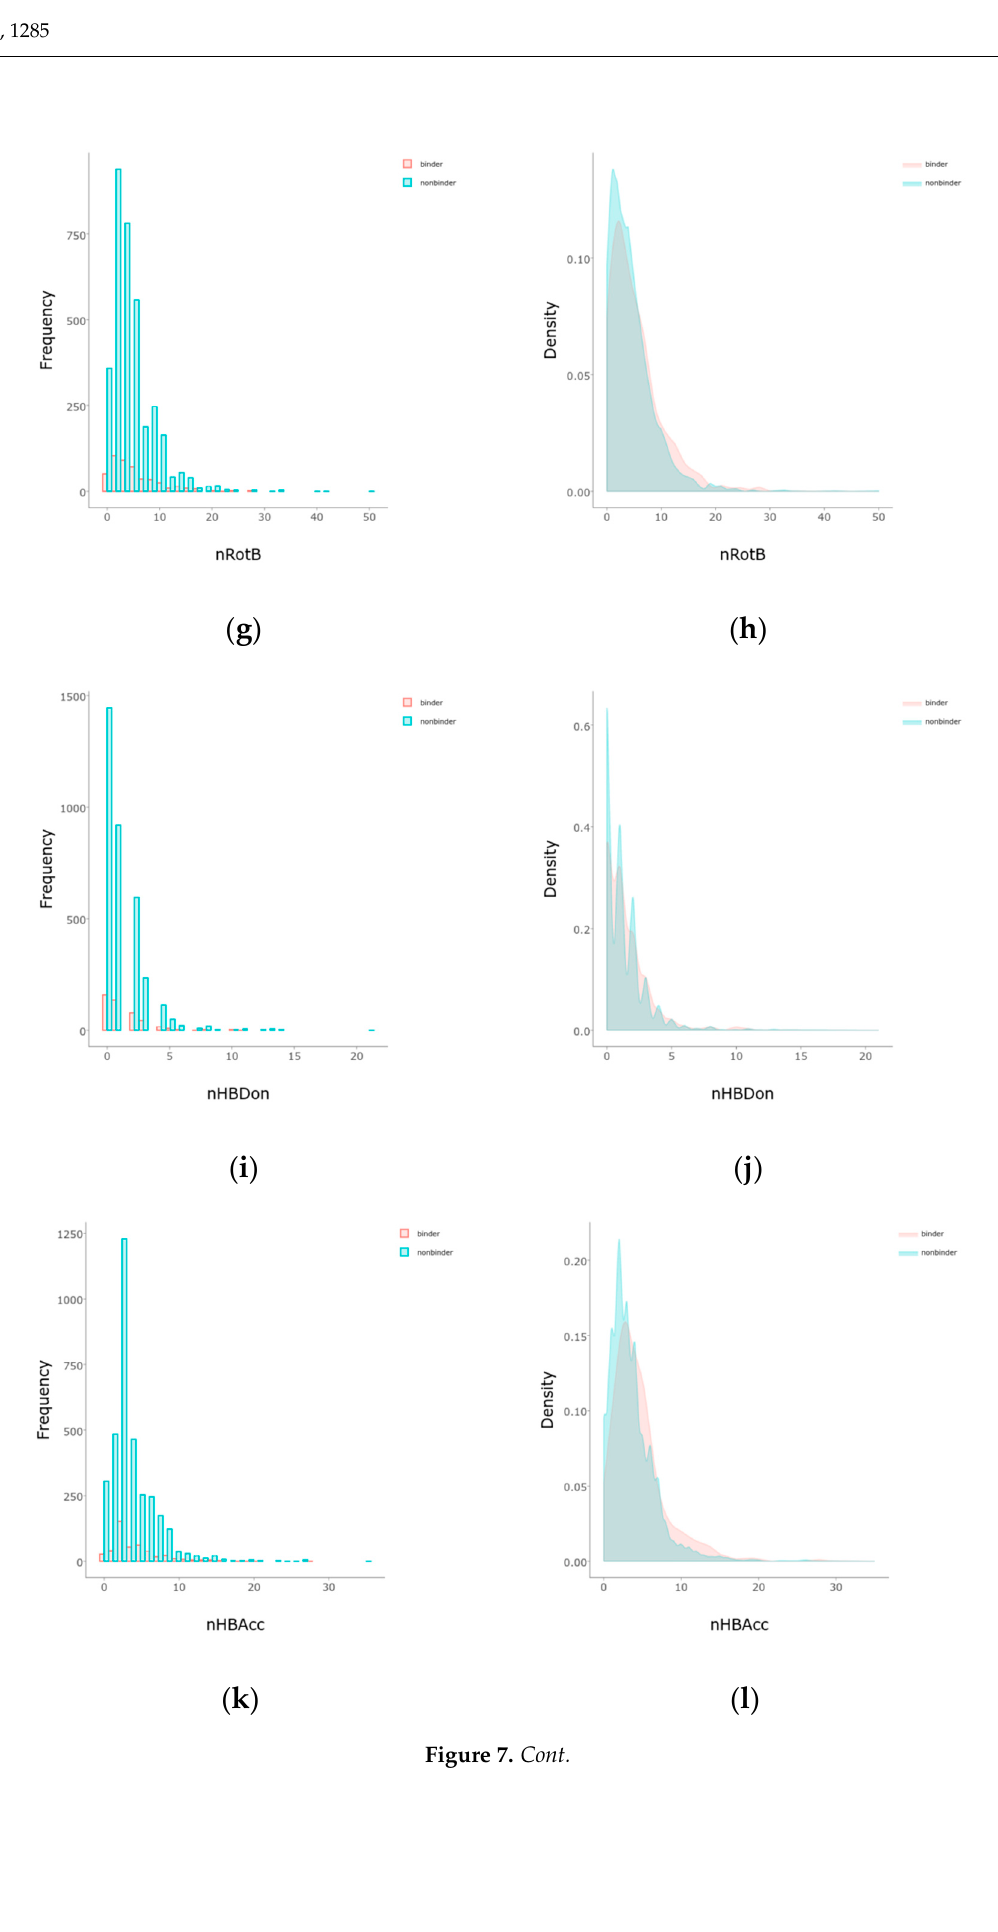
( n ) Figure 7. PUMA: ( a ) principal component analysis; ( b ) balance; and histograms and density plots for binders and non- binders in the evaluation dataset according to: ( c , d ) MW (g/mol); ( e , f ) TPSA (Å 2 ); ( g , h ) number of rotational bonds (nRotB); ( i , j ) number of hydrogen bond donors (nHBDon); ( k , l ) number of hydrogen bond acceptors (nHBAcc); and ( m , n ) Alog P . 2.4. Validation of Docking and Comparison to Other Methods Decoys were generated for the androgen receptor using the DUD-E database (http://wiki.bkslab.org/index.php/DUDE (accessed on 14 February 2021)) and Receiv- er-Operator Curves (ROCs) and Area Under the Curves (AUCs) for the Human, Chimp, and Rat androgen receptor docking scores were calculated and plotted (Figure 8), showing a good separation of true positive from false positives in the most important, i.e., initial parts of the curves. Their values are high, and the chimp protein again shows that it is the most suited with an AUC of 0.832, and an enrichment factor at 1% of 68.92. AUC for human was 0.797, and AUC for rat was 0.744. Comparing our results to a structure-based approach by Trisciuzzi et al. [7], they obtained the highest AUC of 0.76 for structures 2pnu and 2hvc, compared to 0.83 for the Chimp AUC in this work. Using 20 gold-standard reference androgen receptor probe compounds as used by Kleinstreuer et al. [19] (Table 2) shows that there was a good result for predictions of